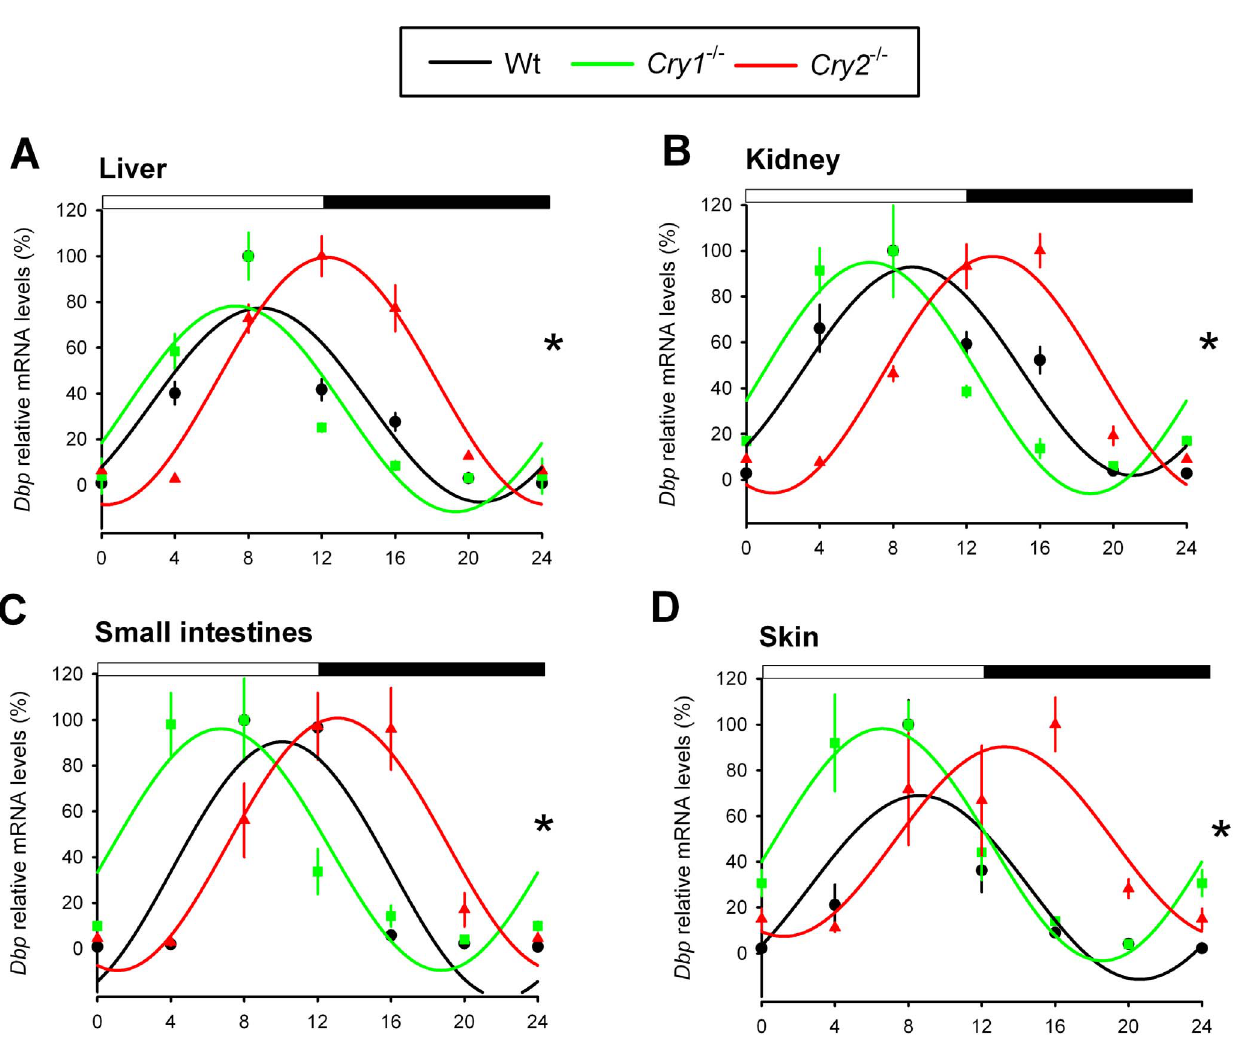
Figure 5. Dbp expression profiles in peripheral tissues of light-entrained Cry1 -/- and Cry2 -/- mice. Relative mRNA expression profiles of Dbp in the liver (A), kidney (B), small intestine (C), and skin (D) of light-entrained (LD 12:12) wild type (black), Cry1 -/- (green) and Cry2 -/- (red) mice, as measured by RT-qPCR. For each genotype, mRNA levels (mean 6 s.e.m) are expressed relative to the peak of expression (set at 100%) and fitted with a wave curve. The two-way ANOVA test revealed a significant effect of genotype and time interaction (*p , 0.05). Data at ZT0 and ZT24 are double- plotted for easier visualization of daily expression. The bar above panels indicates time of light on and off.